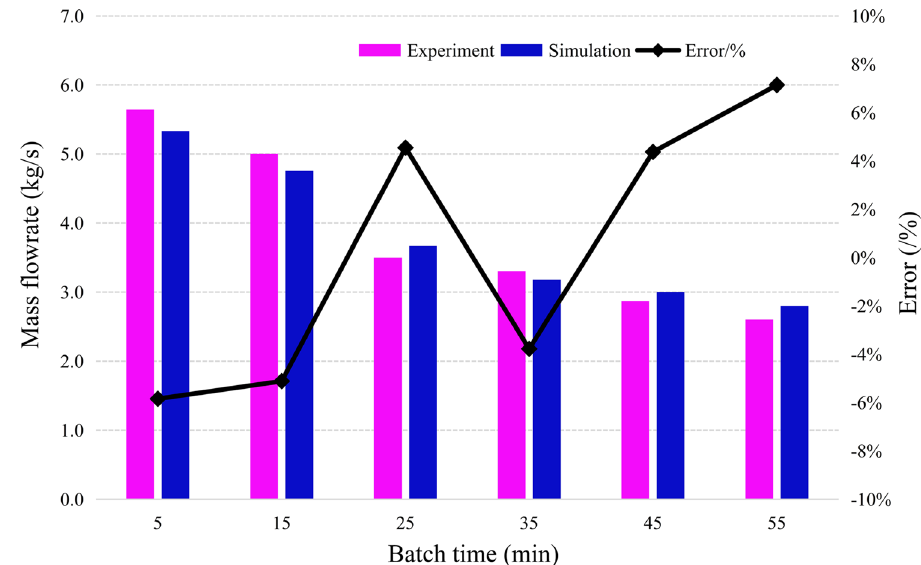
Figure 13: Average mass fl ow of mortar at di ff erent batch times.